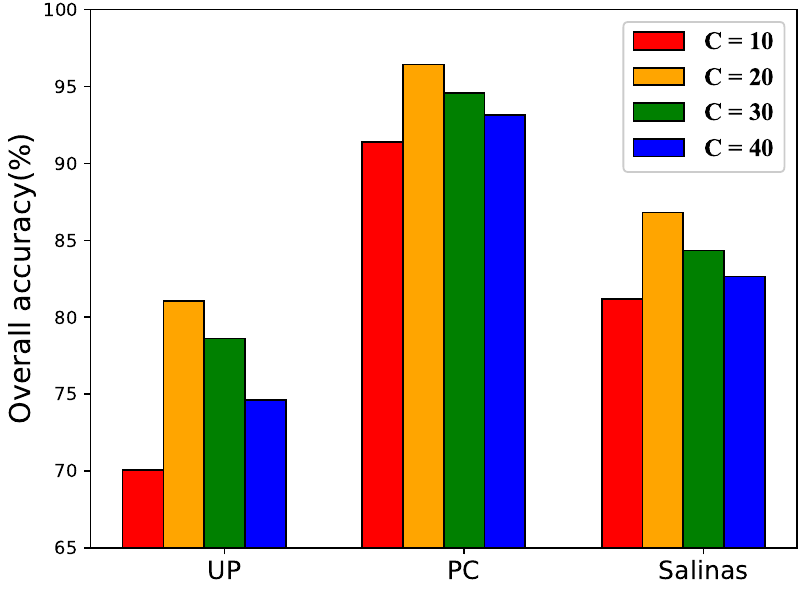
Figure 10. Overall accuracy under different C .